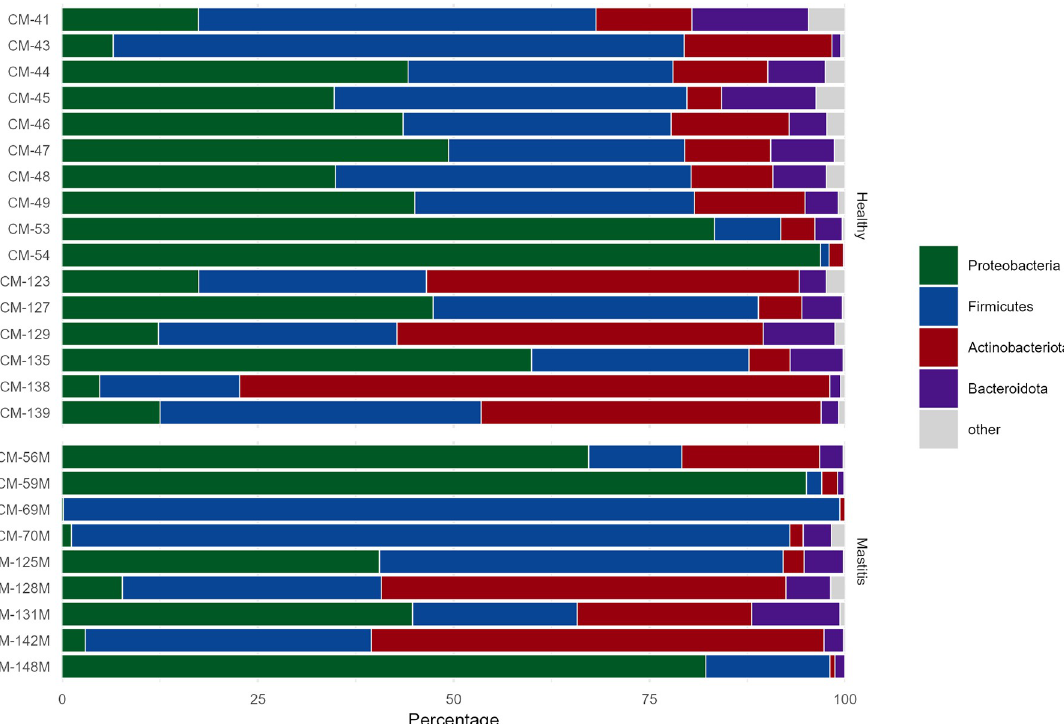
Fig 1. Taxon frequencies (percent of total sample counts) of the most dominant bacterial population in healthy and mastitis camel milk summarized at the phylum level for the 16S rRNA. Rare taxa with a mean abundance of < 1% across all samples are summarized as “Others”. M corresponds to the mastitis